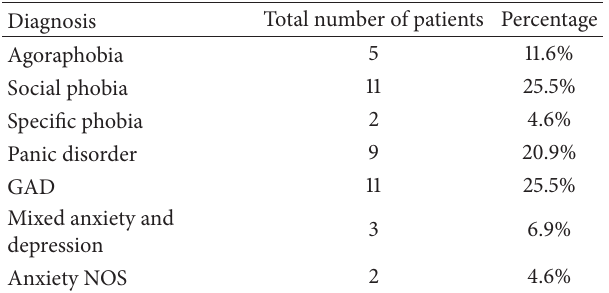
Table 4: Comparative prevalence of eating disorders in both groups (females